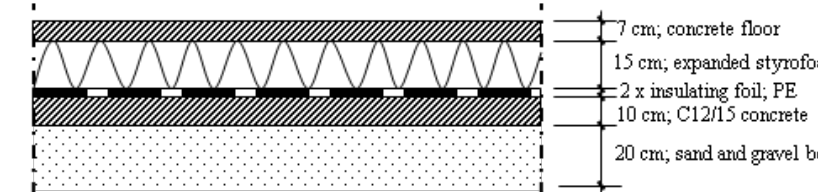
Figure 1: Arrangement of floor